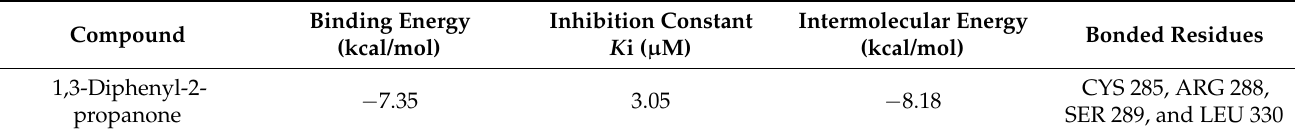
Table 7. The binding energy and interacting residues obtained by calculating the PPAR γ -DPP molecular docking scores. Compound